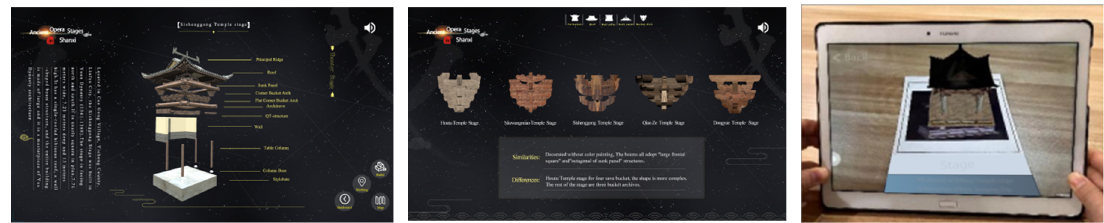
Figure 11. The AR interaction on APP.